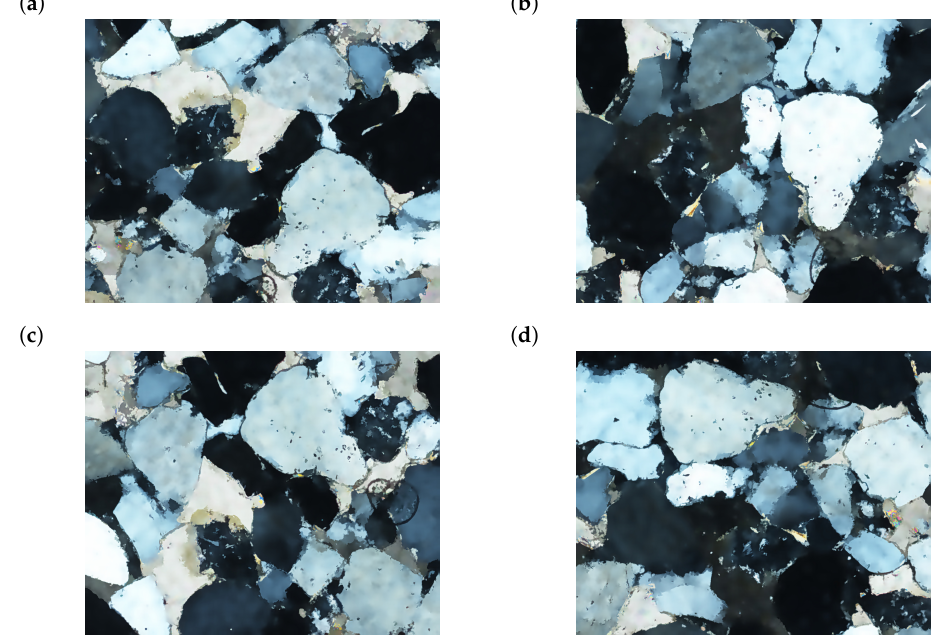
Figure 5. Filtered images: ( a ) Angle 0°, ( b ) Angle 40°, ( c ) Angle 90°, ( d ) Angle